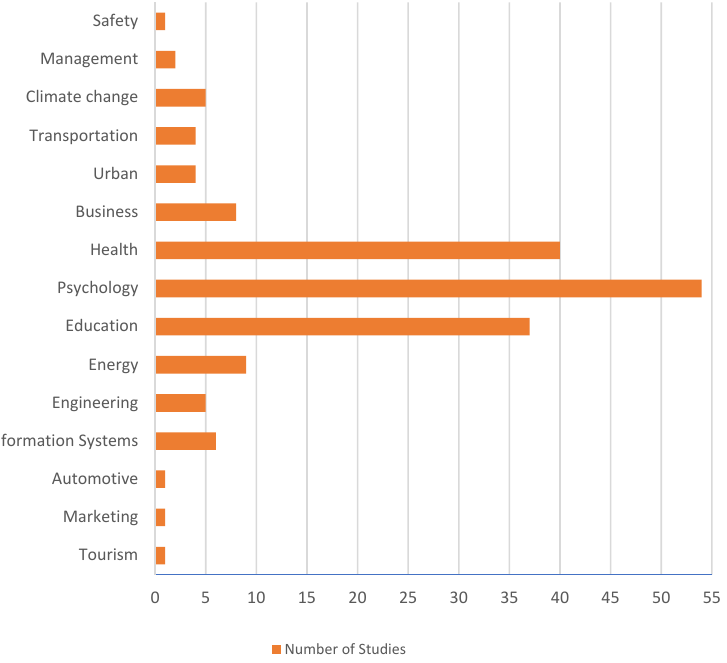
Figure 3. The BCG paper frequencies in application domains. Information 2021 , 12 , x FOR PEER REVIEW Figure 3 . The BCG paper frequencies in application domains. Table 1 . Classification of game elements and their frequencies in BCG studies.